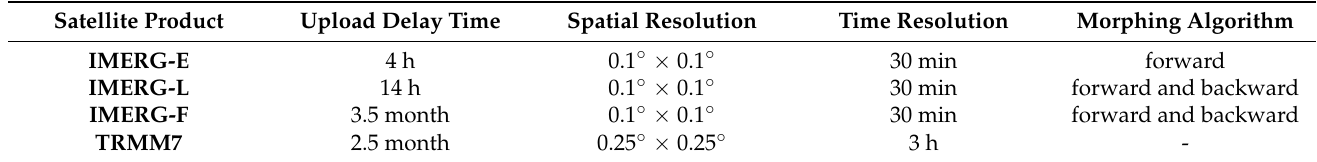
Table 1. Summary of Integrated Multi-satellitE Retrievals for Global Precipitation Mission Level-3 (IMERG-E, IMERG-L, and IMERG-F) and Tropical Rainfall Measuring Mission 3B42 v7 (TRMM7) Satellite Products. Satellite Product Upload Delay Time Morphing